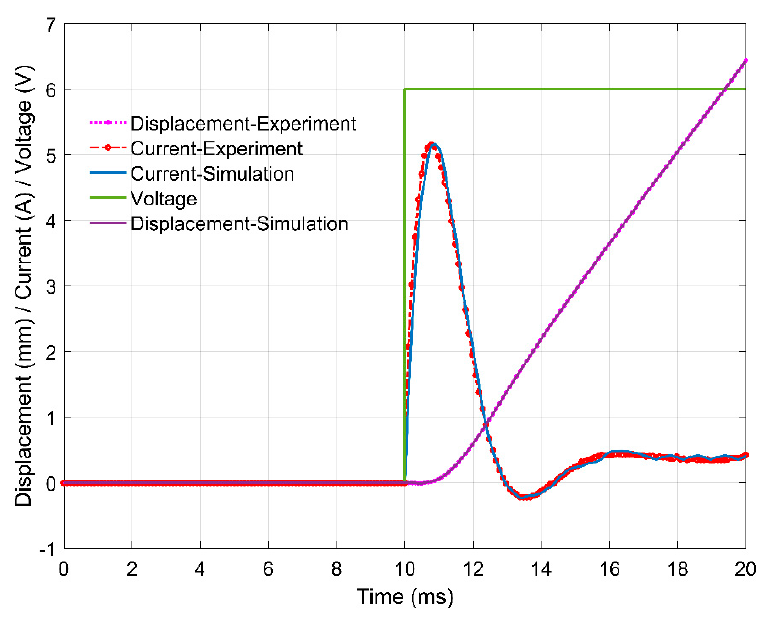
Figure 11. The comparison chart of the current and displacement.